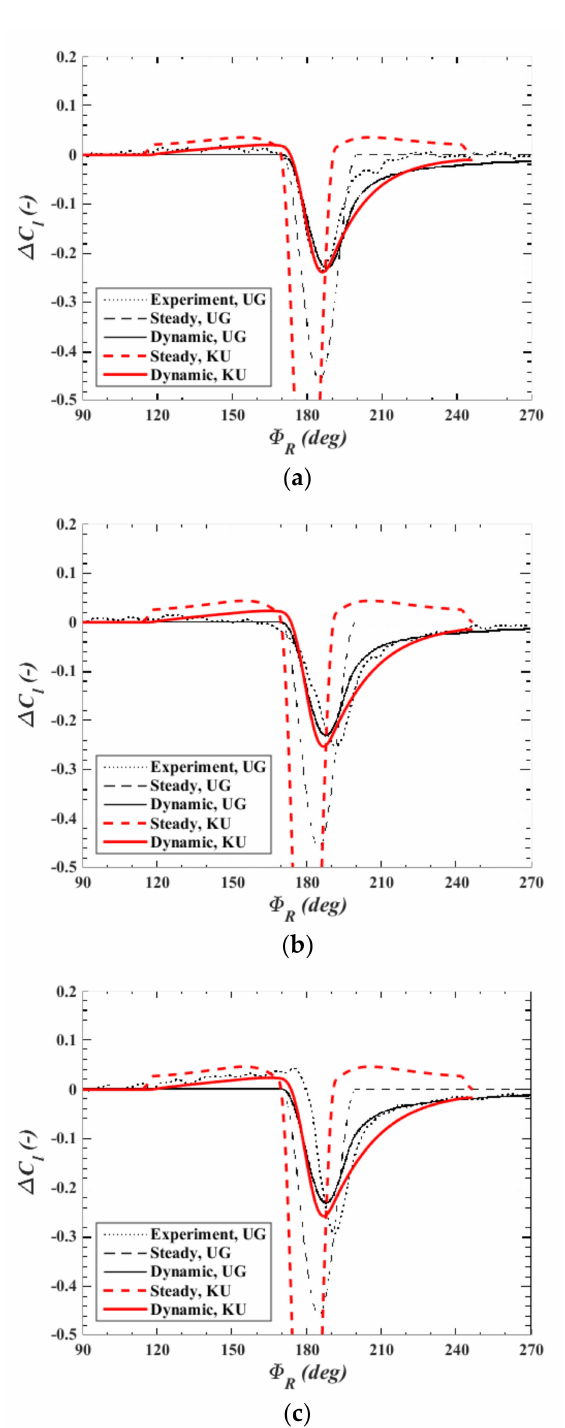
Figure 7. Deviations in the lift coe ffi cient at blade η B = 75% according to the present method with the present threshold, C d = 1.2 [24]: ( a ) Case 1: V T = 36.0 m / s; ( b ) Case 2: V T = 44.1 m / s; ( c ) Case 3: V T = 46.7 m /